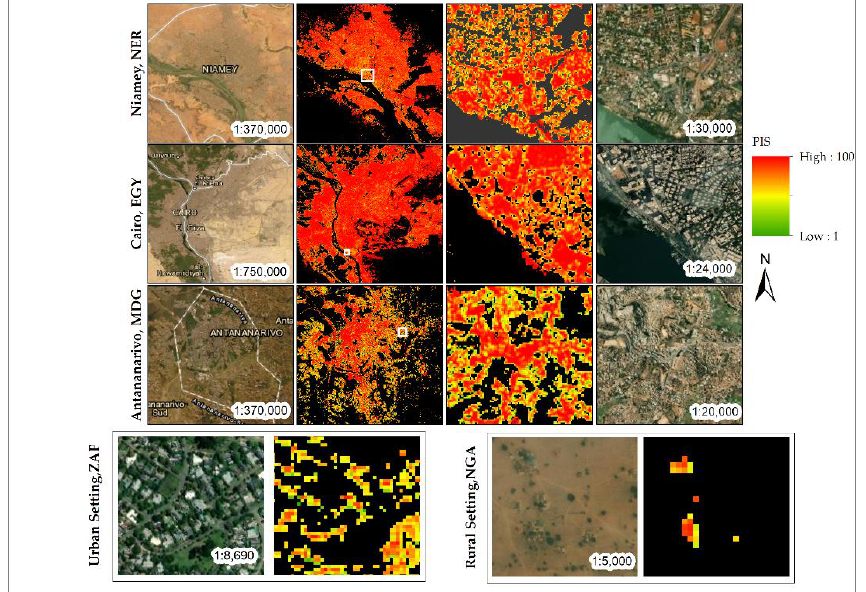
Figure 2. WSF2019-Imperviouness. Top to bottom: areas of Niamey (Niger), Cairo (Egypt), Antananarivo (Madagascar), and suburban(left) and rural (right) areas in South Africa and Nigeria. Percent impervious surface (PIS) legend from >0% to 100% with country-specific minimum and maximum values. Additional subsets (white boxes) compared against Very High Resolution (VHR) imagery. Black areas: pixels outside the WSF2019 settlement mask.